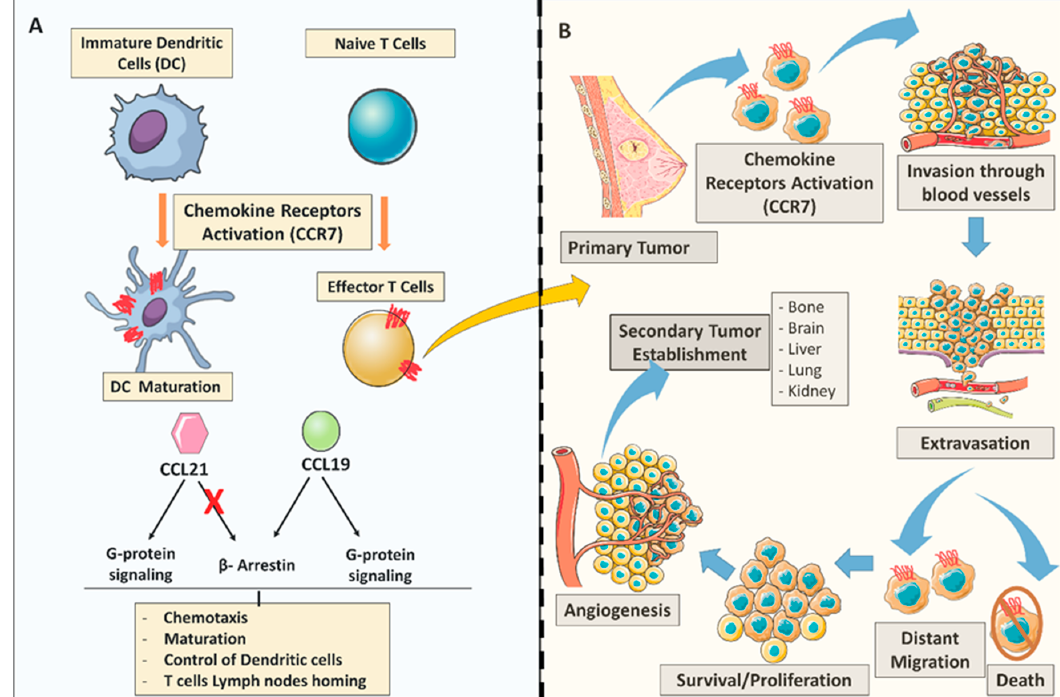
Figure 1. General C-C Chemokine receptor 7 (CCR7) chemokine dual role in the immune system and breast tumor metastasis. ( A ) CCR7 role in the adaptive immune system; CCL19/CCL21 chemokine